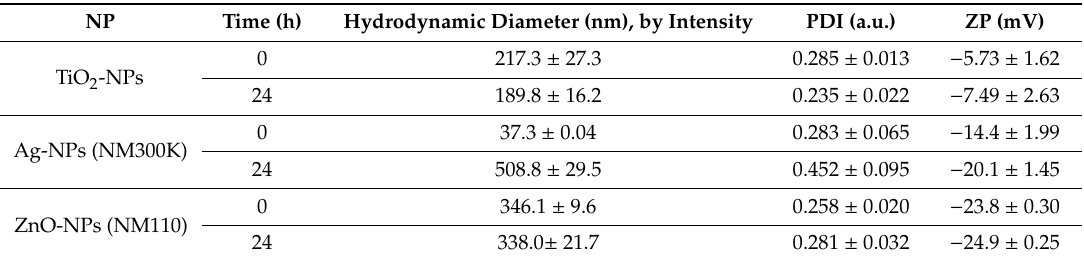
Table 3. Hydrodynamic diameter and zeta potential (ZP) of nanoparticle (NP) working dispersions (concentration 212 µ g / mL, corresponding to 75 µ g / cm 2 ). For analysis, samples were diluted 1:10 in pure water. Numbers are given as mean ± standard deviation (SD) ( n = 3). PDI: polydispersity index; a.u.: arbitrary